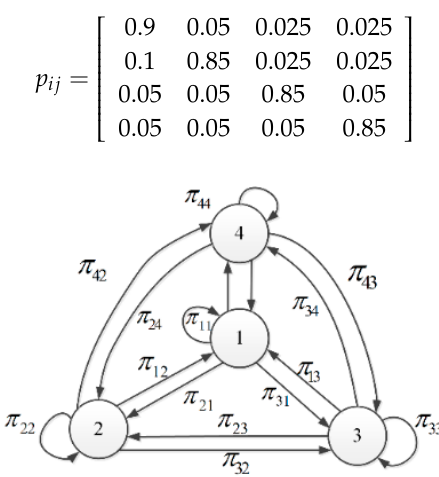
Figure 5. State transition probability diagram among models of HA.